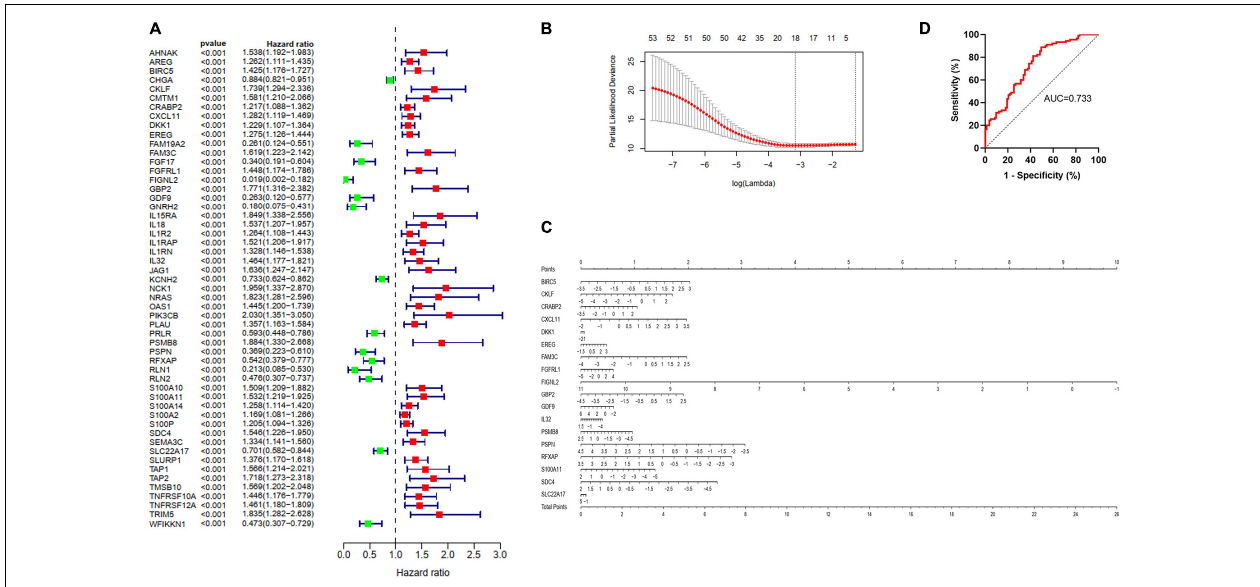
FIGURE 2 | Identification and validation of the immune predictive model. (A) A forest plot showing associations between the 53 proteins whose p value were less than 0.001 and overall survival in the training group. Unadjusted hazard ratios are shown with 95% confidence intervals. (B) The cross-test for selecting parameters in the LASSO model. Lambda represents the selected parameters, and partial likelihood deviance is plotted against log (lambda). (C) Nomogram predicting the probability overall survival. Eighteen genes were used to assign the points and draw a line depending on the corresponding values. “Total points,” The sum of these 18 genes’ points makes up the “Total points” and can predict overall survival. (D) The ROC curve of the TCGA ( n = 173) training model for predicting patients’ overall survival.